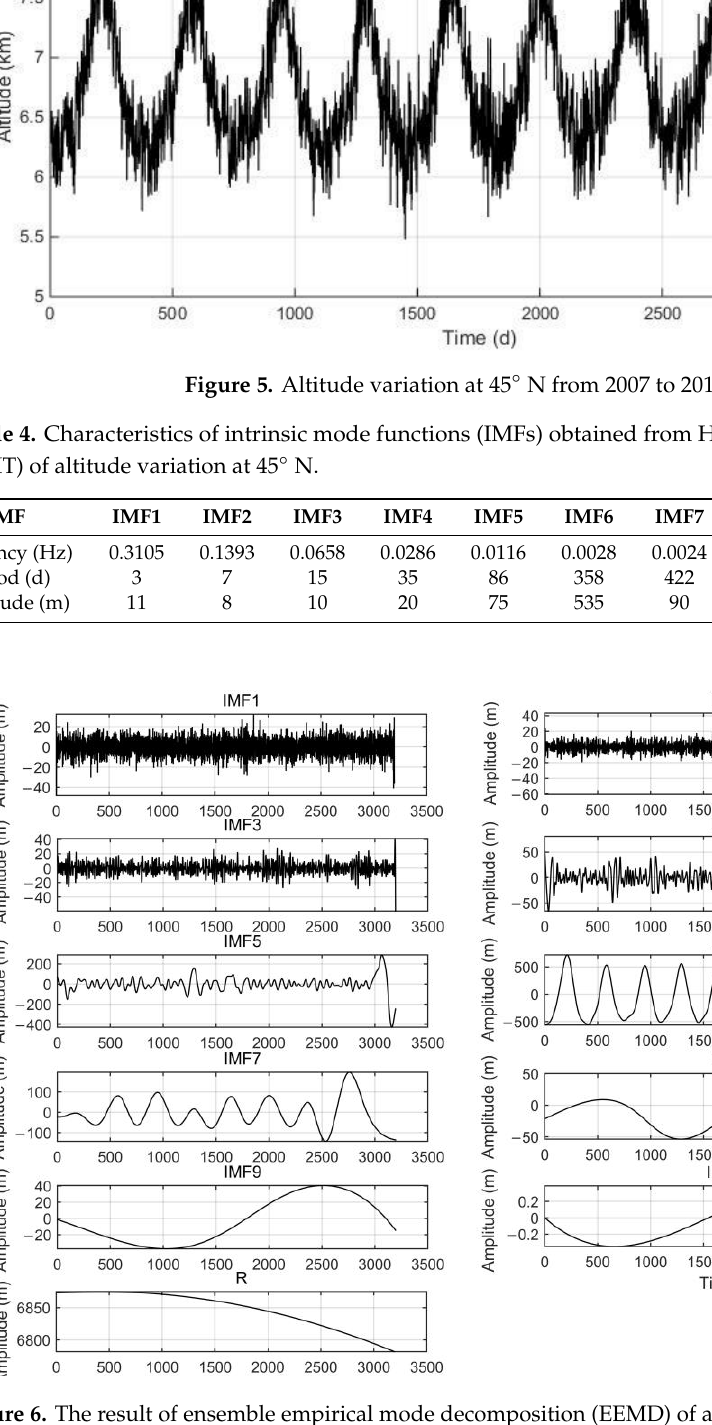
Figure 6. The result of ensemble empirical mode decomposition (EEMD) of altitude variation at 45° N from 2007 to 2015.